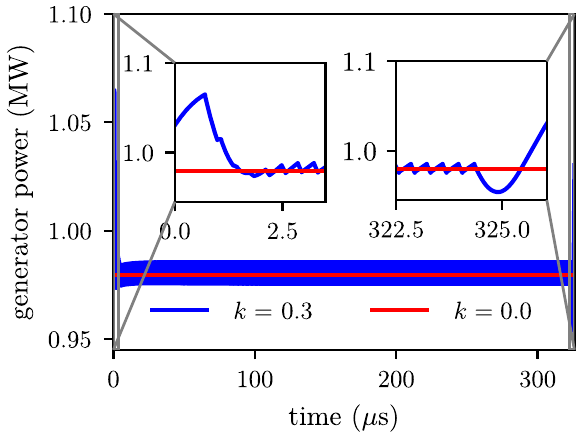
FIG. 11. Evolution of the cavity voltage, synchronous phase of the beam (red solid line), and the phase of the synchronous particle (red dotted line) during the ramp for the energy program and the filling factor shown in Fig. 10.